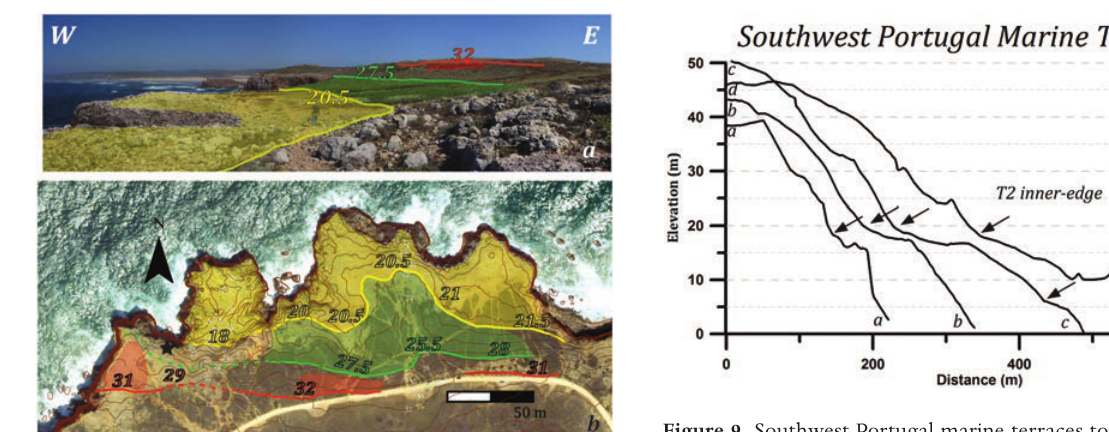
Figure 9. Southwest Portugal marine terraces topographic sec- tion profiles, surveyed with GPS- RTK: (a) North Carrapateira; (b) South Carrapateira; (c) Eastern Ingrina; (d) Western Ingrina. T2 inner edges are visible in all profiles at equivalent elevations and T1 inner edges are only visible at Ingrina profiles, due to erosion at Carrapateira.